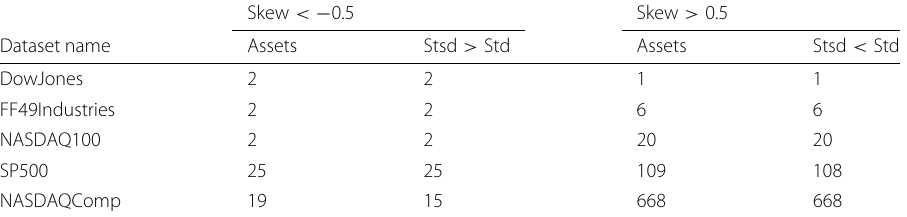
Table 3 Classification of the assets belonging to each dataset in terms of skewness (Skew), standard semideviation (Stsd) and standard deviation (Std) Skew < − 0.5 Skew >